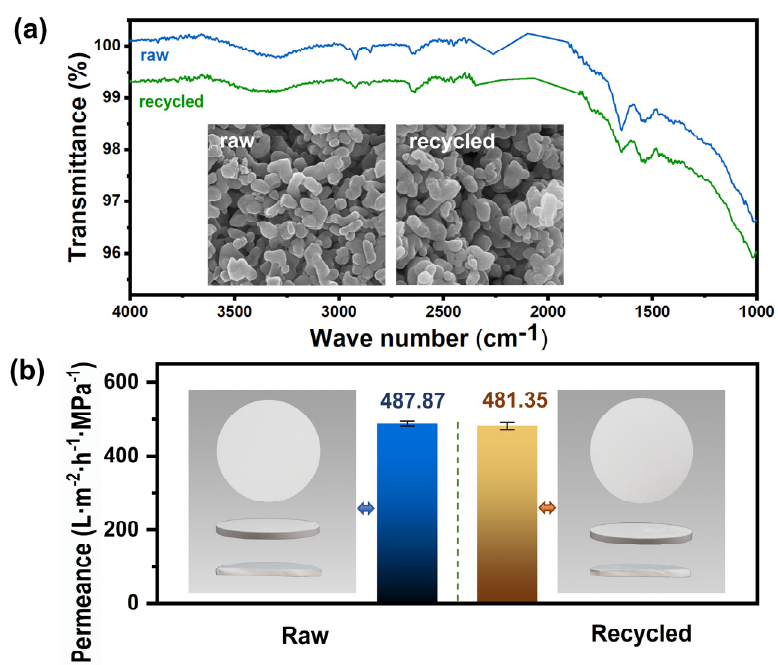
Figure 12. The comparison of the raw and the recycled ACM: ( a ) FT-IR spectra and SEM images; ( b ) the photograph and pure water permeance.